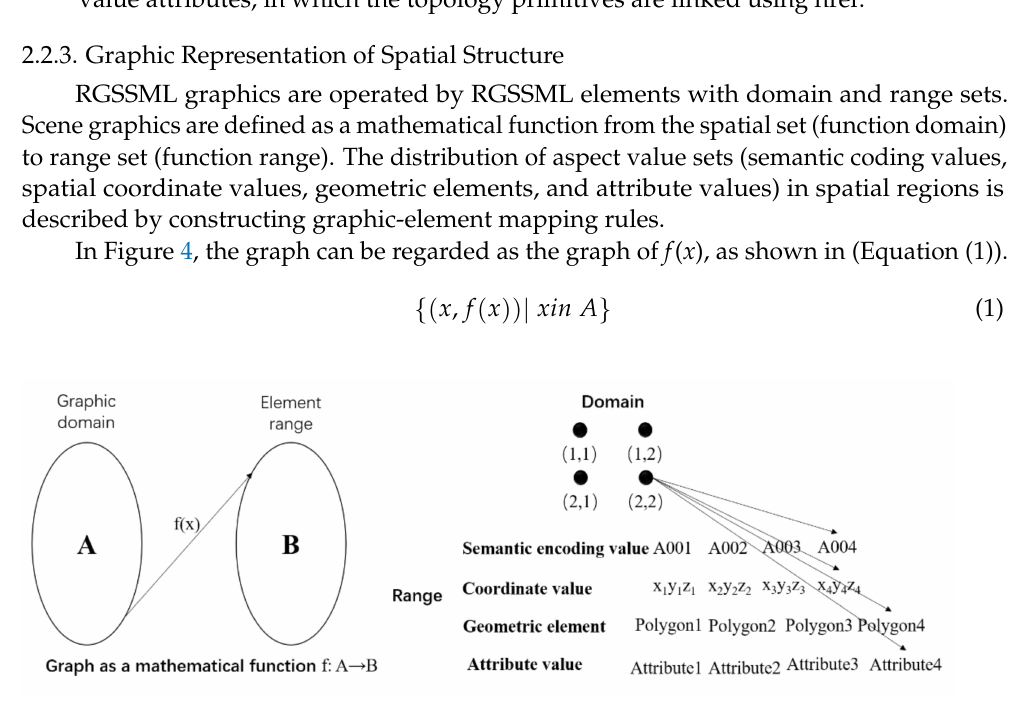
Figure 4. Graphic functions and mapping